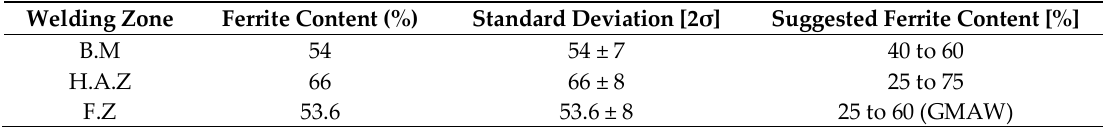
Figure 2. Microstructure of EN 1.4162 specimen: ( a ) General view; ( b ) BM; ( c ) HAZ—0.08 mm; ( d ) FZ. Table 1. Ferrite content measurement of the EN 1.4162